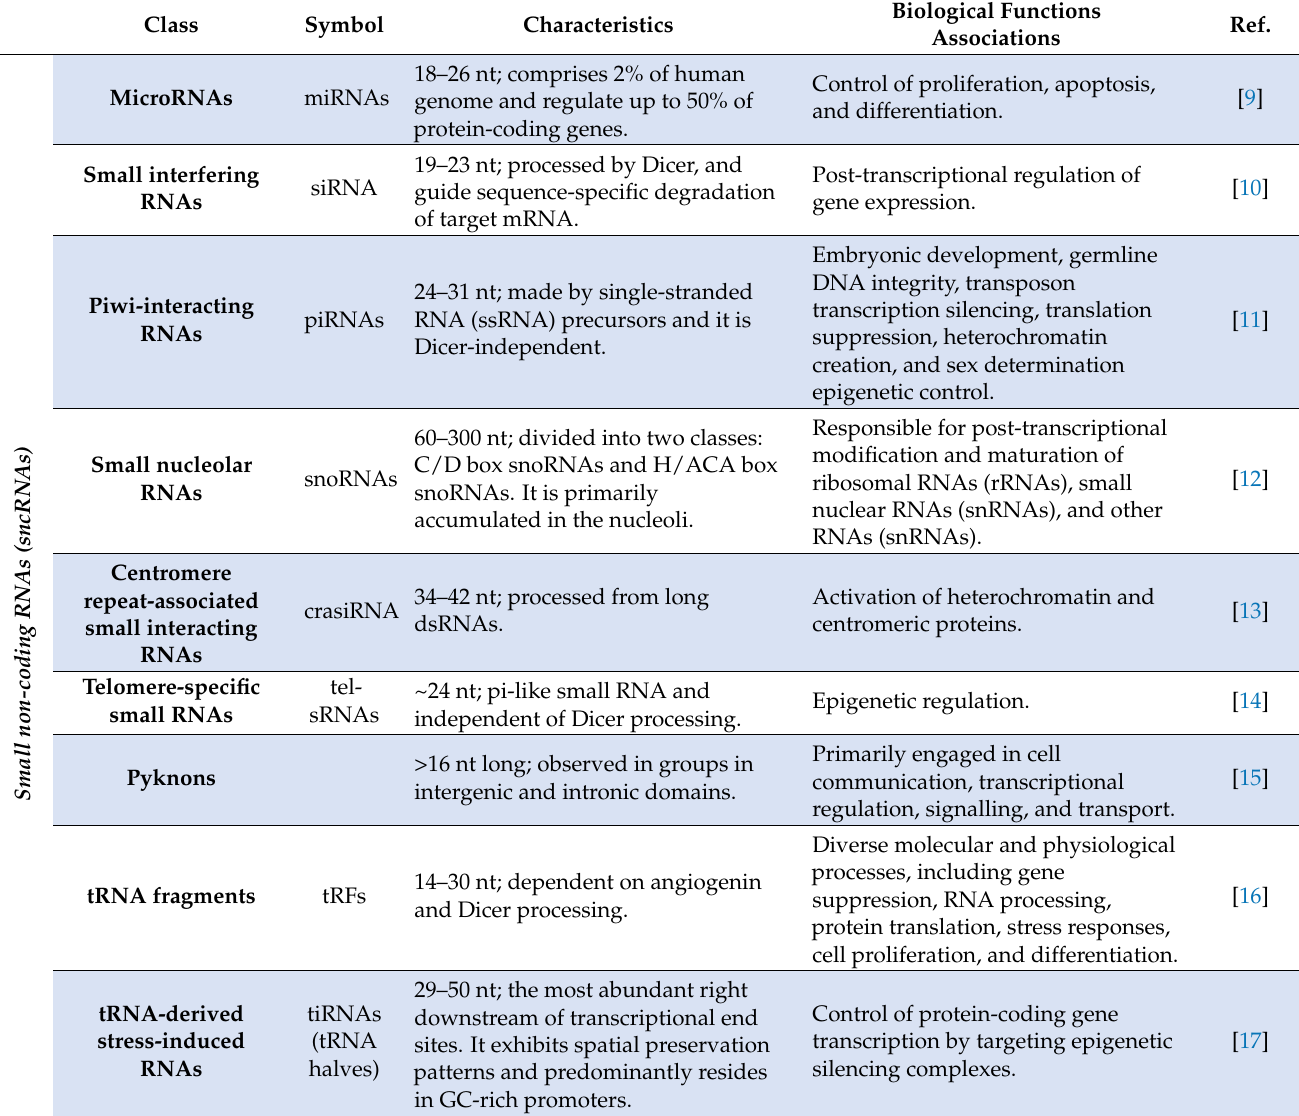
Table 1. Mammalian non-coding RNA